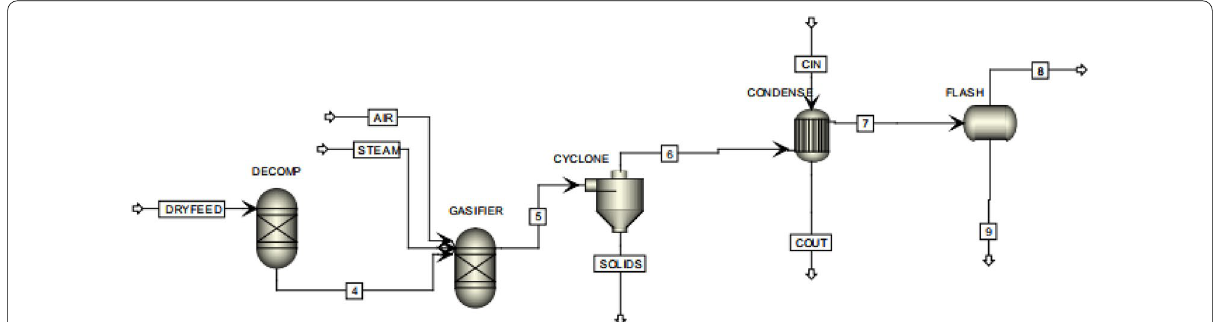
Fig. 5 SCB gasification model on ASPEN Plus (Mavukwana et al.